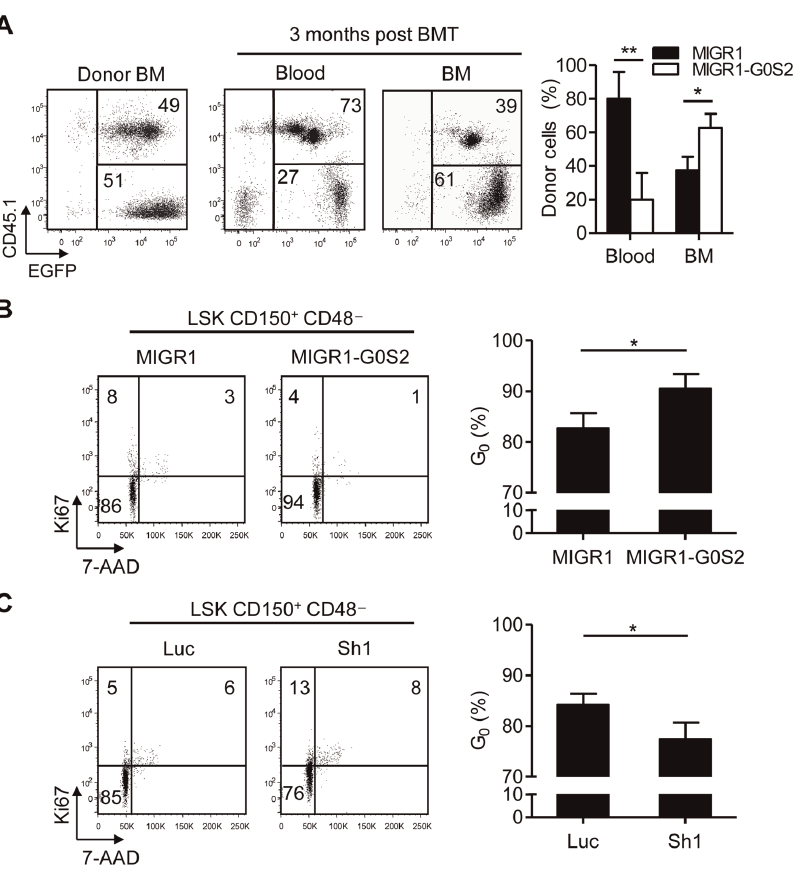
Figure 4. G0S2 enhances the quiescence of hematopoietic stem cells. (A) To analyze the reconstitution potential of G0S2-overexpressing BM cells relative to wild-type BM cells, we performed a competitive transplantation with a mixture of BM cells transduced with the MIGR1 or MIGR1-G0S2 retrovirus ( n =5). EGFP + CD45.1 + and EGFP + CD45.1 2 cells were derived from MIGR1 and MIGR1-G0S2 BM cells, respectively. The data represent two independent experiments. (B) The role of G0S2 in HSC quiescence was examined using a gain-of-function model. Flow cytometric analyses of Ki67 and 7-AAD were performed in LSK CD150 + CD48 2 cells purified from chimeric mice transplanted with cells containing the control or G0S2 retrovirus ( n =3–4). Quiescent HSCs were defined as Ki67-negative cells (G 0 ) with a 2n DNA content. (C) Flow cytometric analyses of Ki67 and 7-AAD were performed in LSK CD150 + CD48 2 cells purified from mice transplanted with G0S2-shRNA or the control retrovirus ( n =4–5). *, P , 0.05 and **, P , 0.01 (two-tailed Student’s t